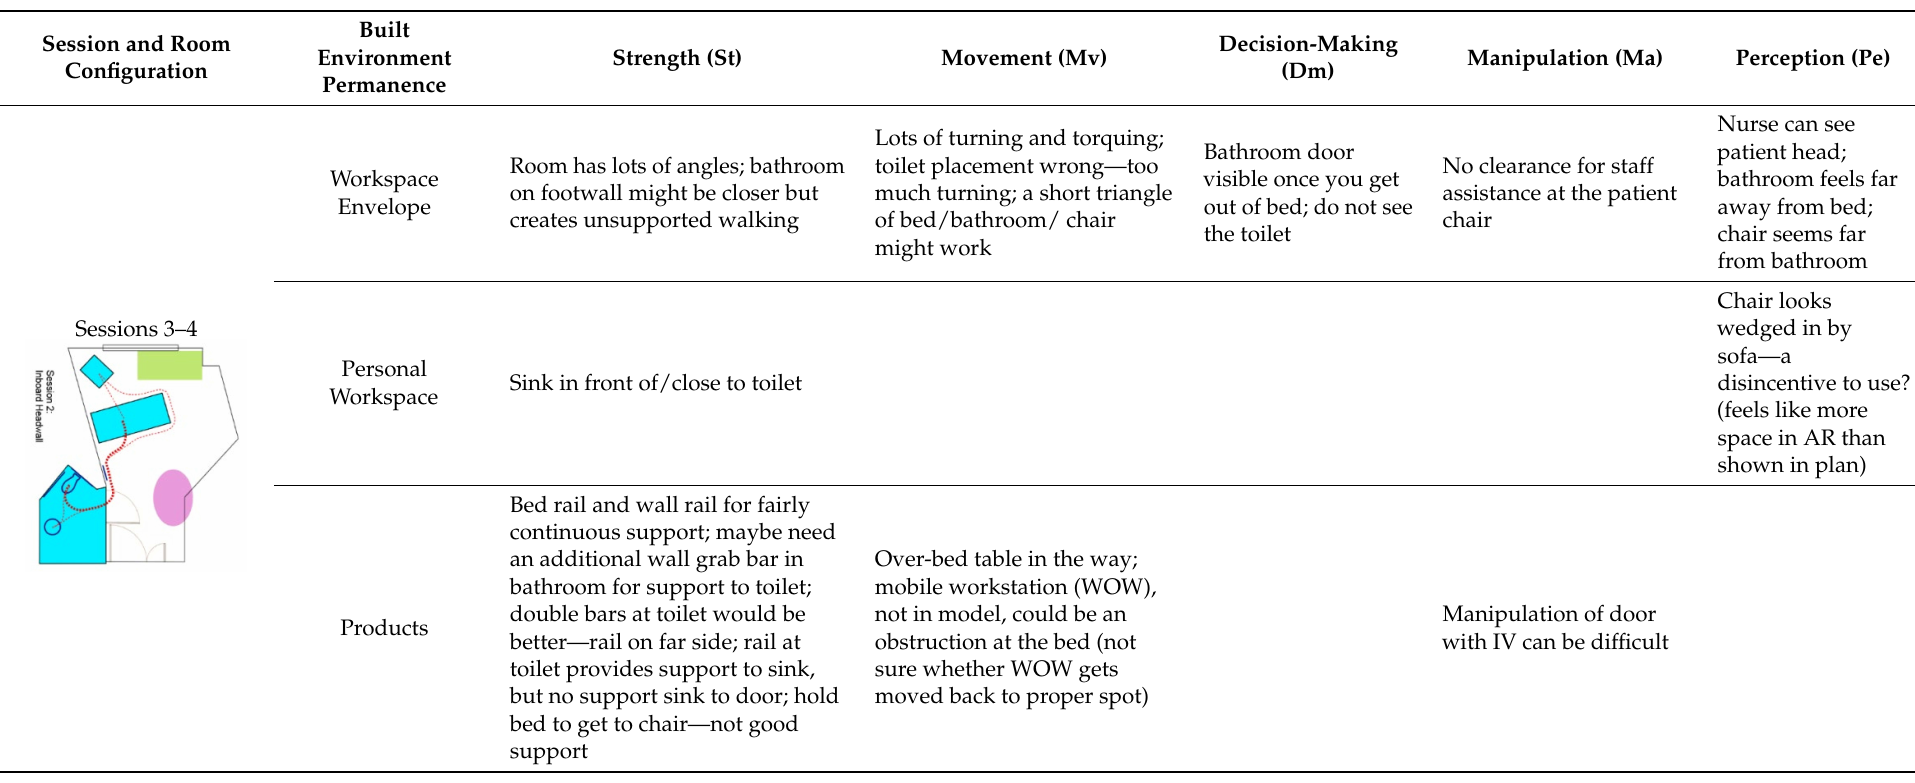
Table 3. Session 3–4 Feedback (Room 2—Inboard